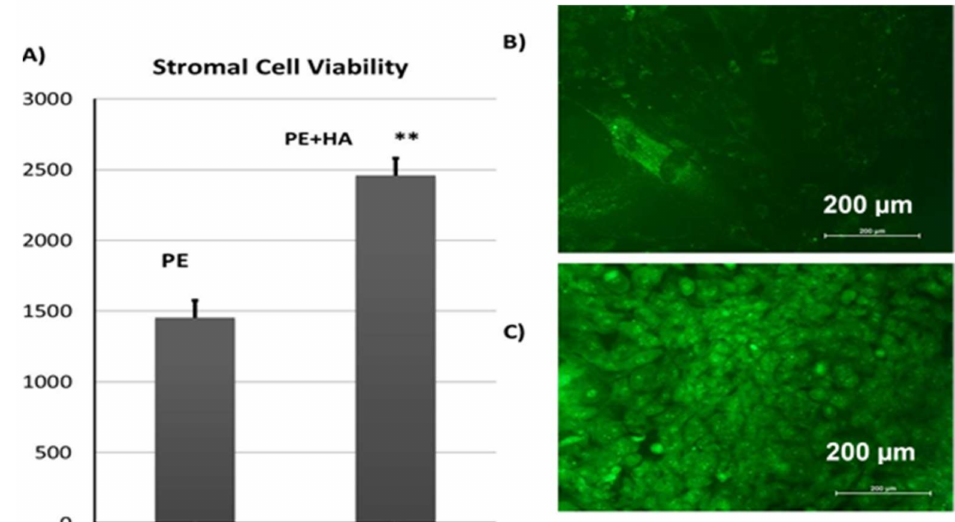
Figure 10. ( A ) AlamarBlue ® assay of CL1 cells cultured on porous polyethylene and polyethylene + hydroxylapatite scaffolds; ( B ) CL1 cells grown on a polyethylene scaffold; ( C ) CL2 cells grown on polyethylene + hydroxylapatite scaffolds stained with acridine orange, which stains all nucleated cells green. The magnification used was 10 ×